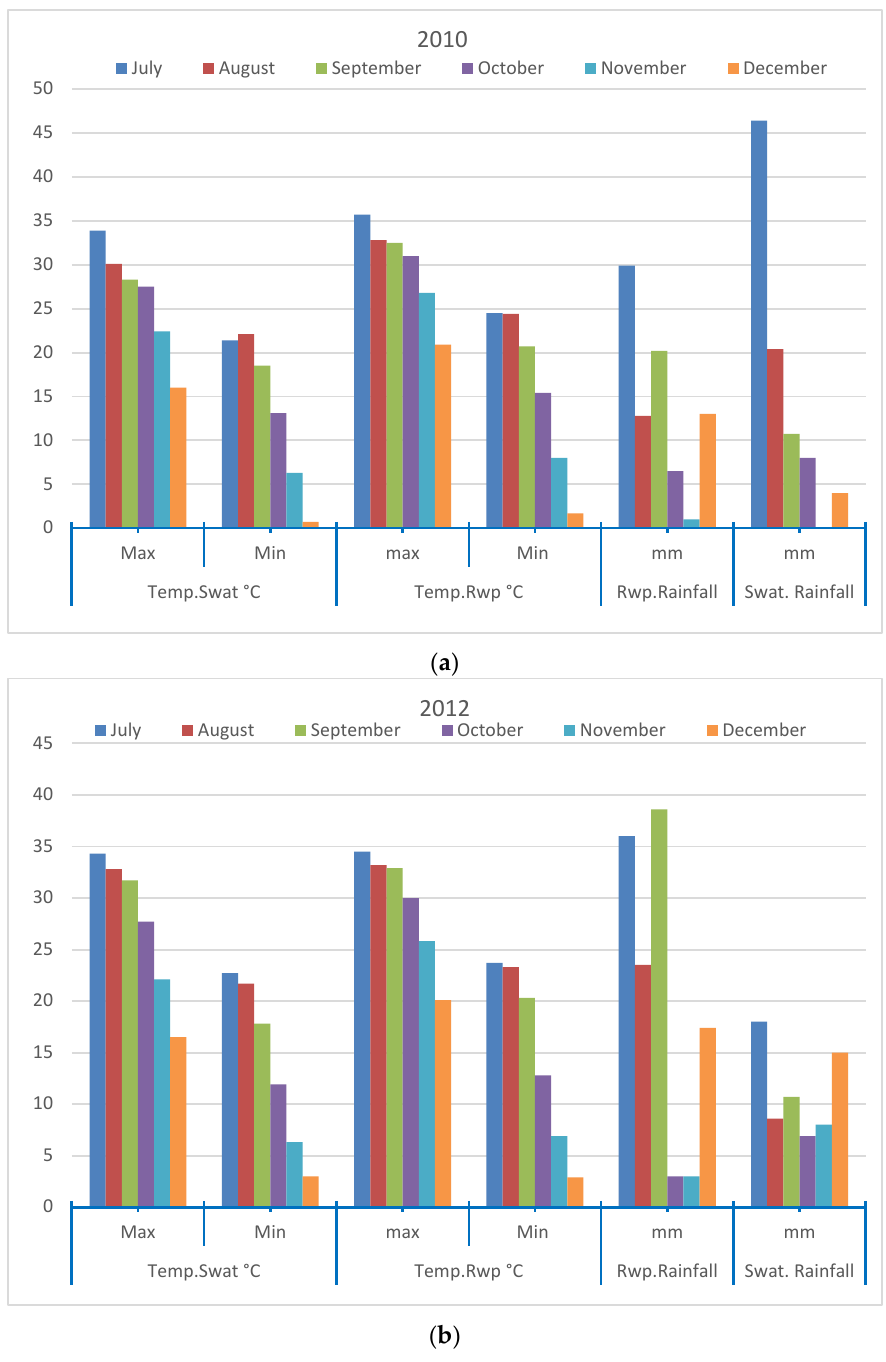
Figure 4. Climate indices for Rawalpindi-Islamabad and Swat for year 2010 and 2012. ( a ) 2010; ( b ) 2012.